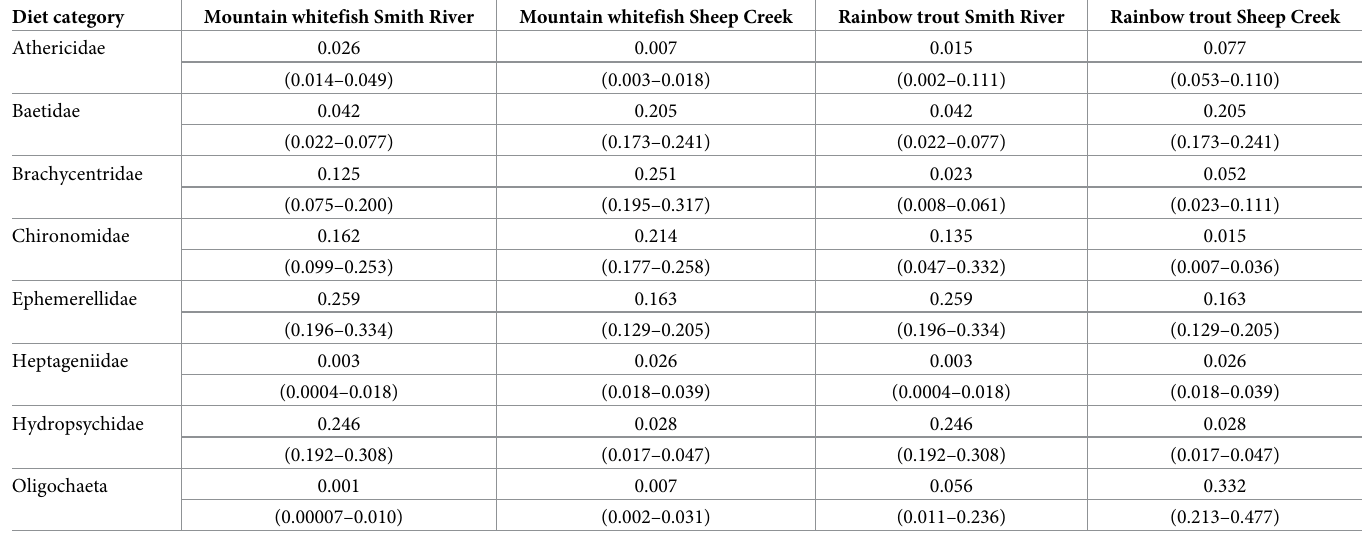
Table 2. Estimated food item proportions. The estimated proportions of total food items in the diets of mountain whitefish and rainbow trout in the Smith River and Sheep Creek by taxon. Estimates are derived from generalized linear models, and confidence intervals (95%) are shown in parentheses. Only the eight most common taxa in fish diets are listed.